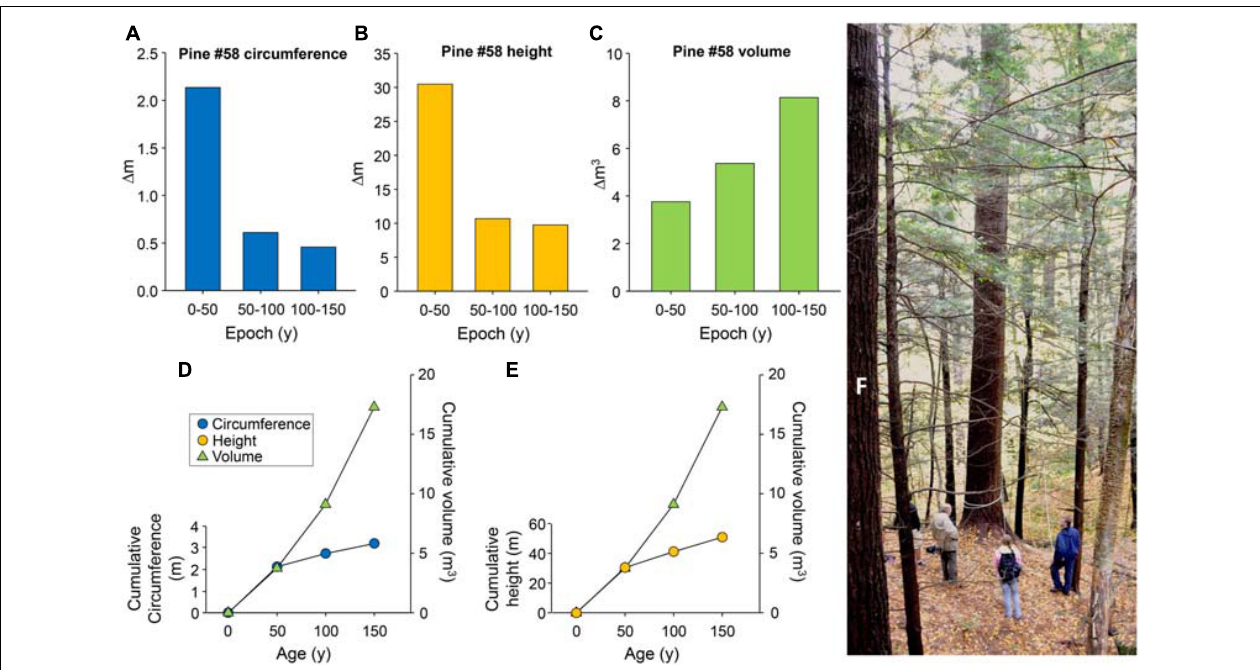
FIGURE 1 | Changes in circumference, height and volume of a stand-grown individual eastern white pine (Pine #58) in three 50-y intervals. Upper panels (A) Change in circumference during 0–50, 50–100, and 100–150 years. (B) Change in height between 0–50, 50–100, and 100–150 years. (C) Change in above-ground tree volume (trunk plus limbs) between 0–50, 50–100, and 100–150 years. Lower panels (D) Cumulative circumference at 50, 100, and 150 years compared to cumulative above-ground volume. (E) Cumulative height at 50, 100, and 150 years compared to cumulative above-ground volume. On each lower panel initial slopes were matched to reflect the rapid change in circumference and height during the first 50-years interval. Note that volume is a proxy for above-ground carbon. Values for circumference, height and volume of Pine #58 were determined by a combination of direct measurement and chronosequence and described in the text and in Supplement. (F) Pine #58 (center) being readied for climbing and